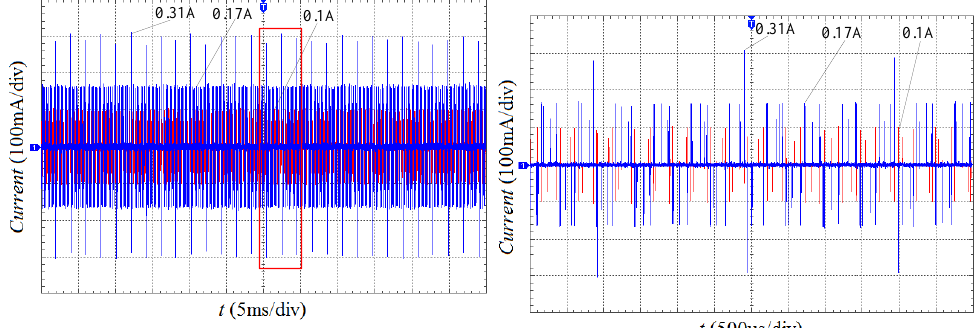
Figure 23. Experimental common-mode leakage current for DZIPWM (blue line) and DZICMV (red line). (The enlarged view of the red box in the left figure is shown in the right figure.)